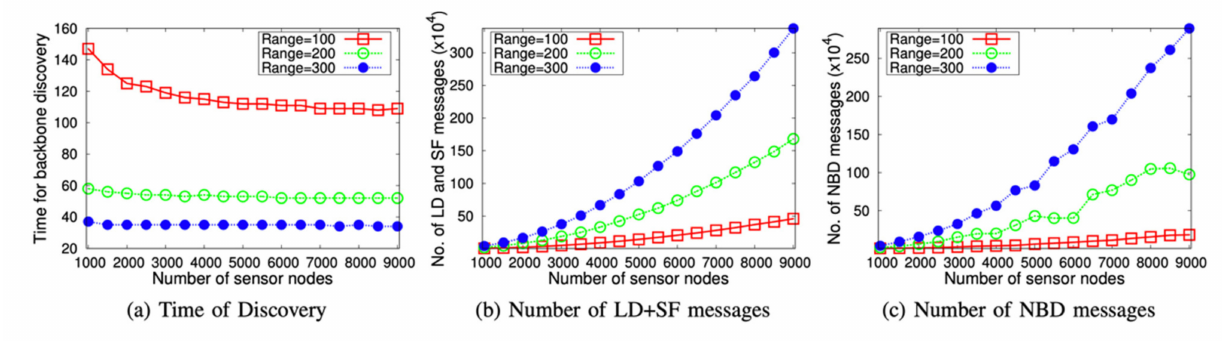
Figure 5. LBD with larger LSNs [39]. ( a ) Time of Discovery ( b ) Number of LD + SF messages ( c ) Number of NBD